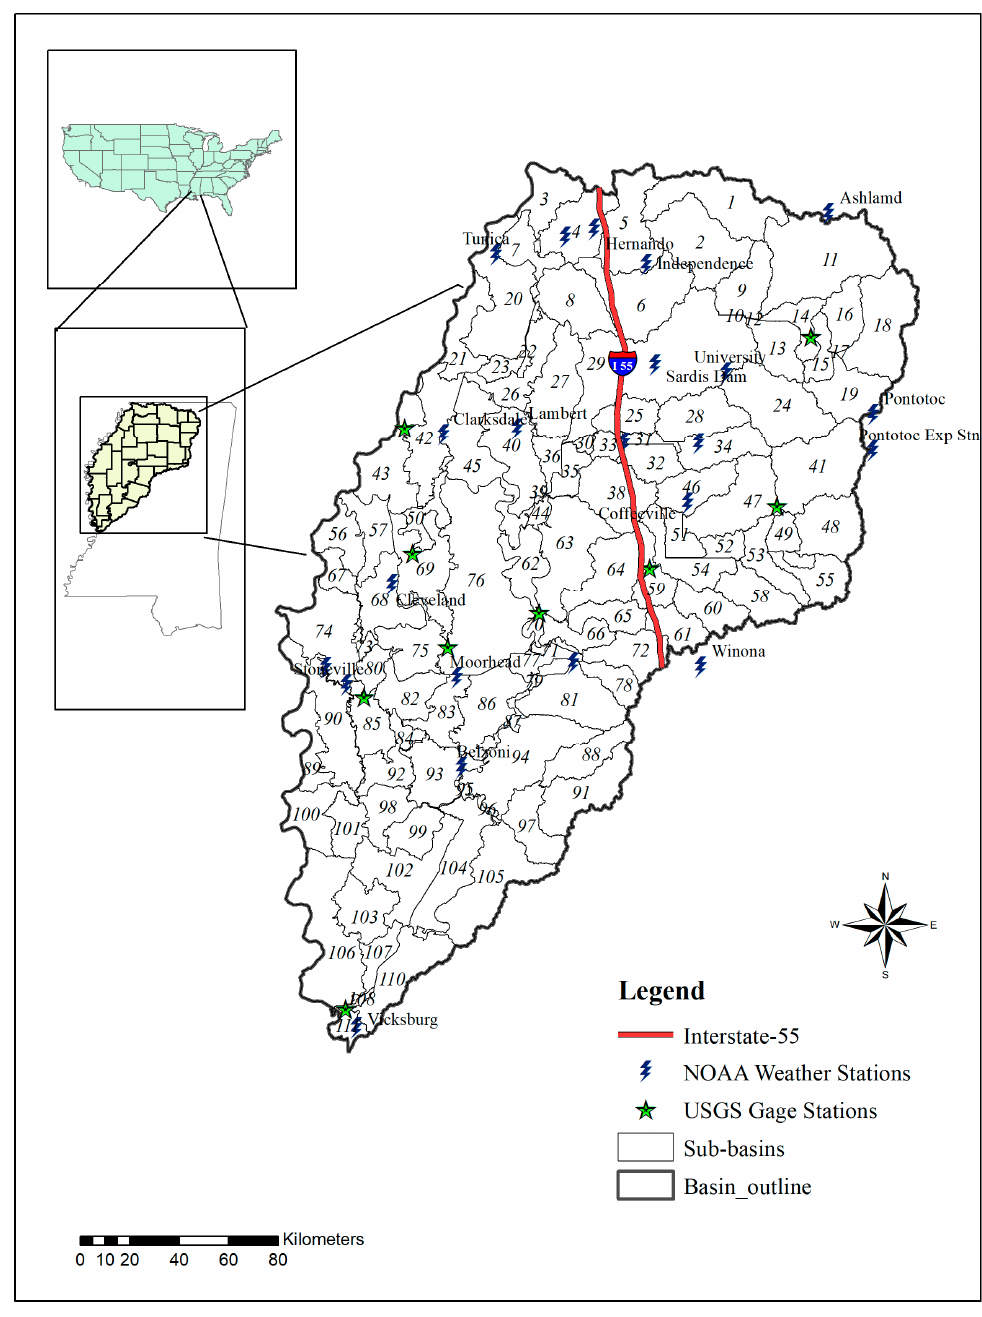
Figure 1. Watershed location showing weather stations and USGS gages. Table 1. List of predominant soils based on area coverage and clay silt sand percentages.